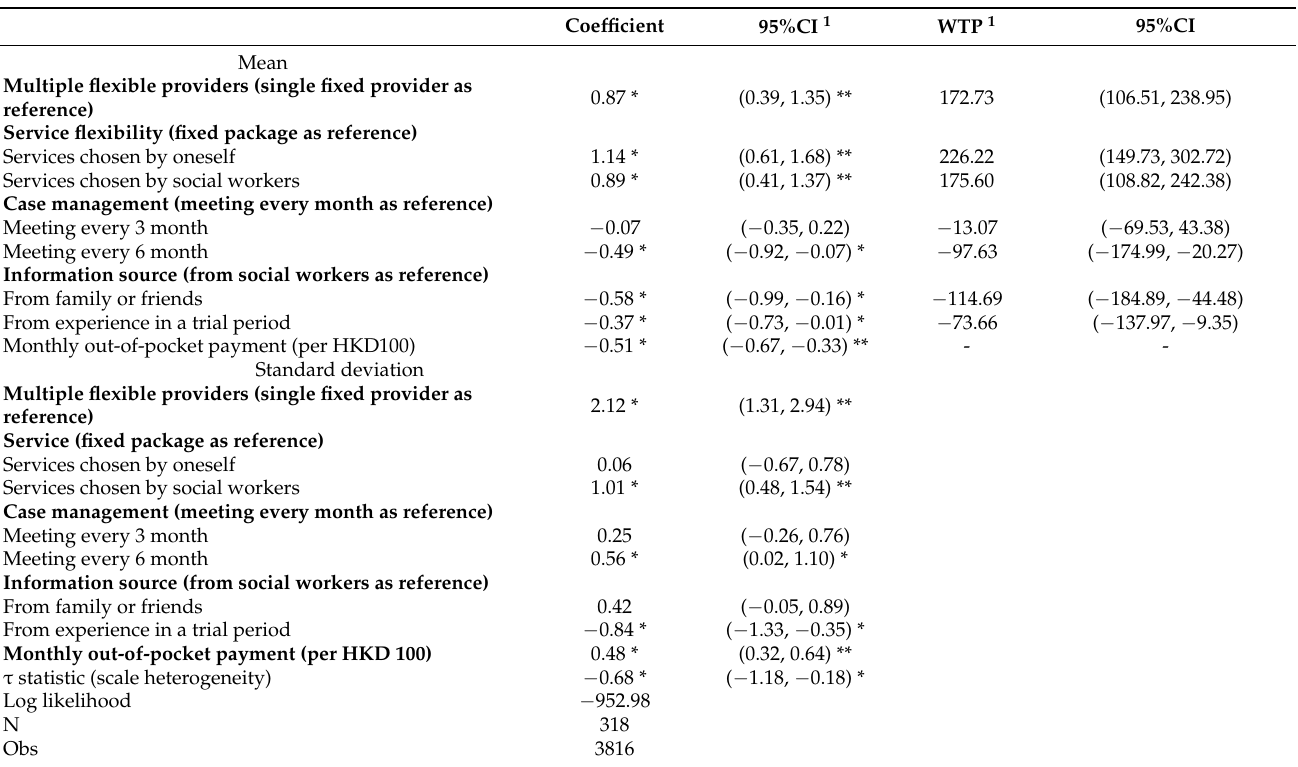
Table 3. Generalized multinomial logistic model estimates and willingness to pay.